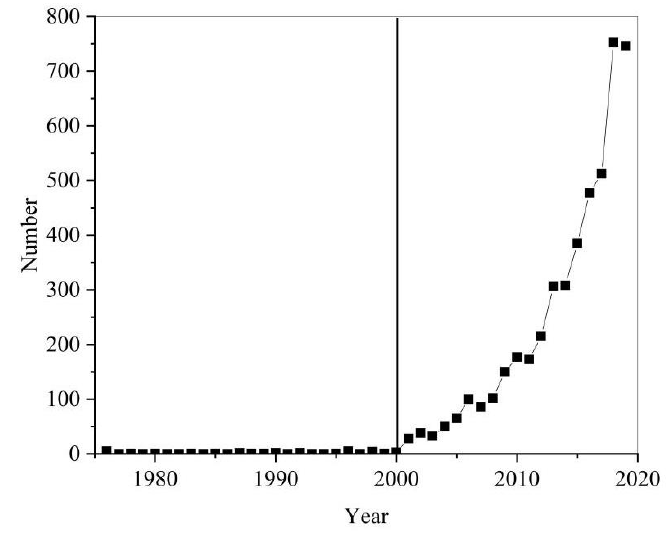
Figure 3. Research trend graph. (This is the result of the number of documents retrieved in the Web of Science TM based on the keyword “urban rain flood model”. The black vertical line represents the turning point).